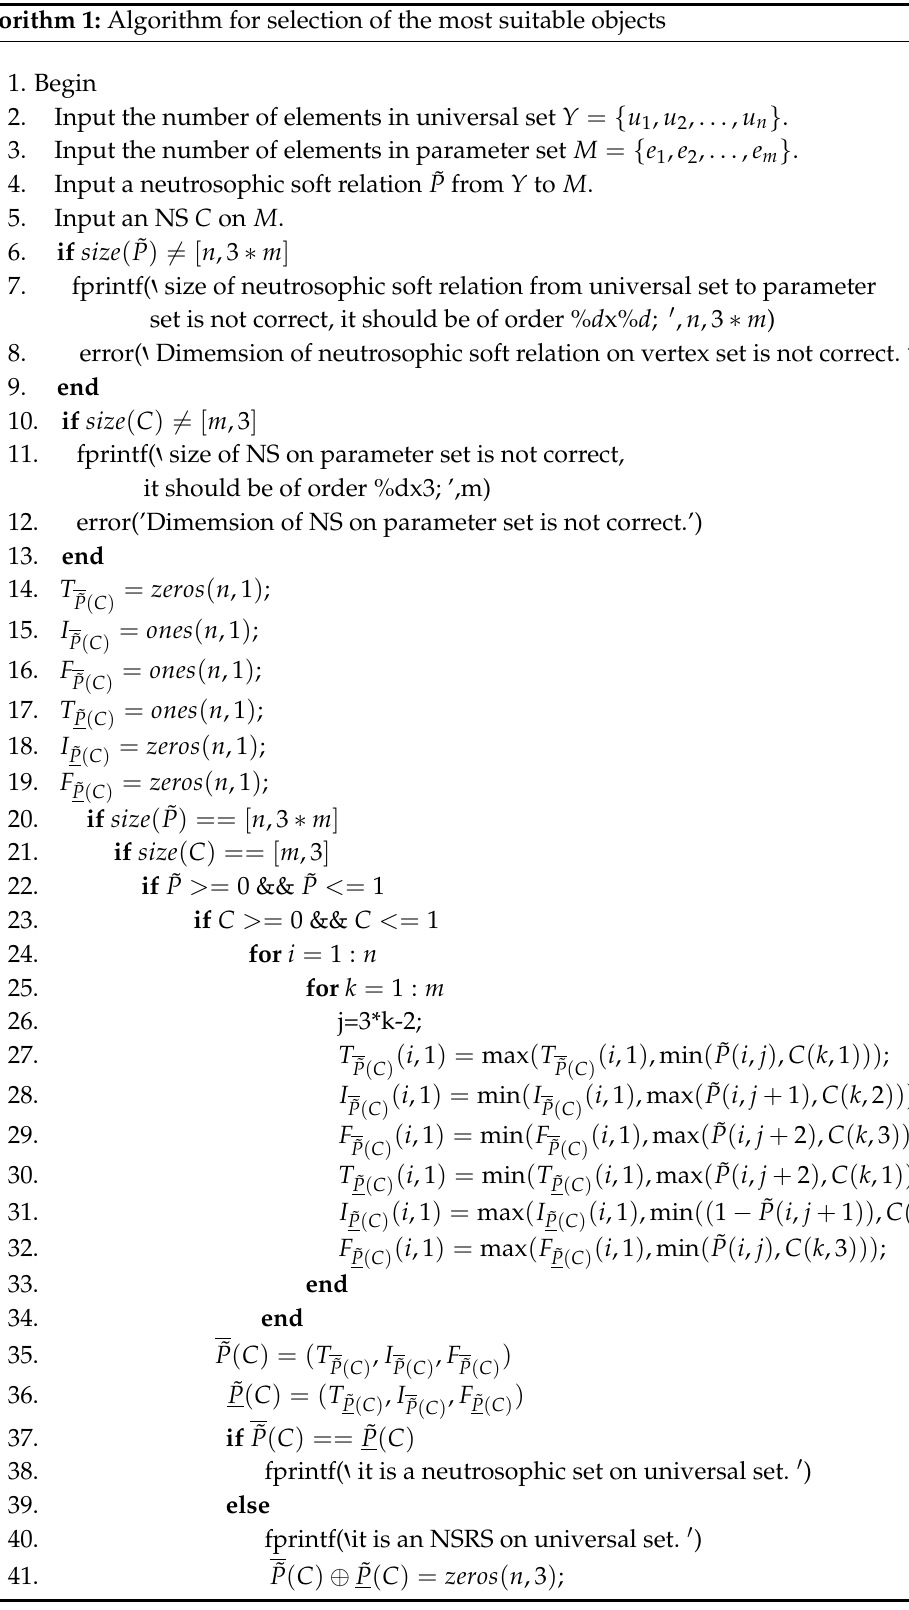
Algorithm 1: Algorithm for selection of the most suitable